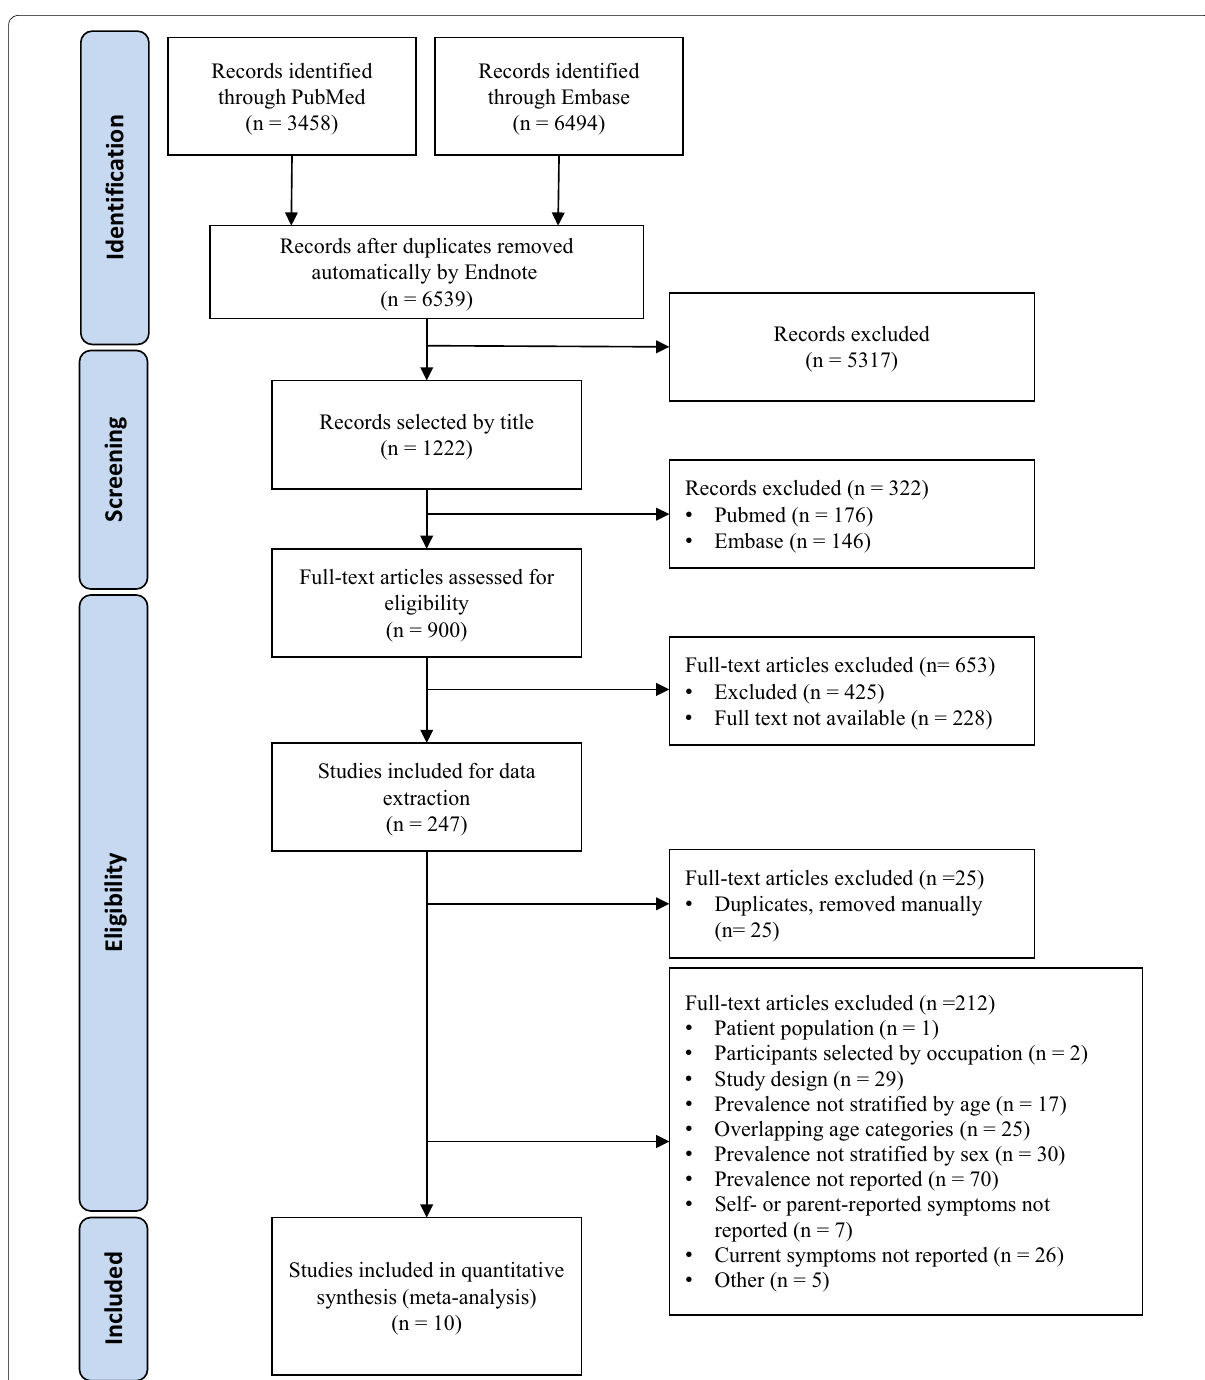
Fig. 1 PRISMA flow chart for literature